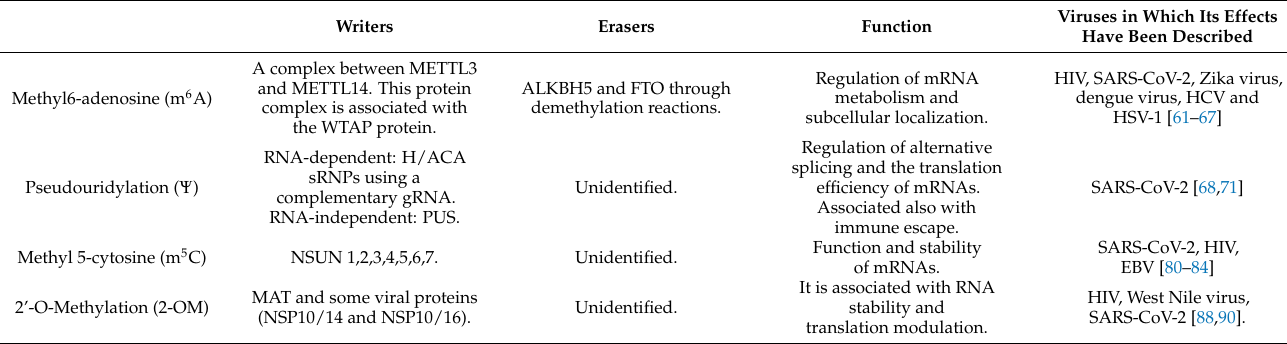
Table 1. RNA modifications through writer and eraser